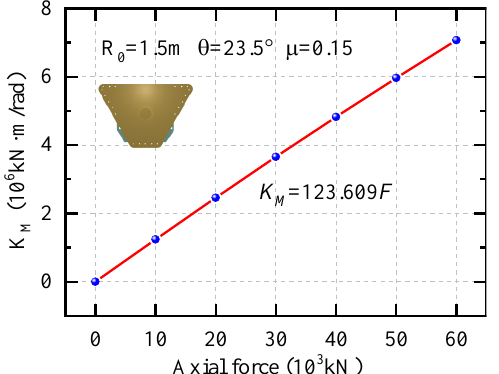
Figure 8. The rotational constraint stiffness of UHS.